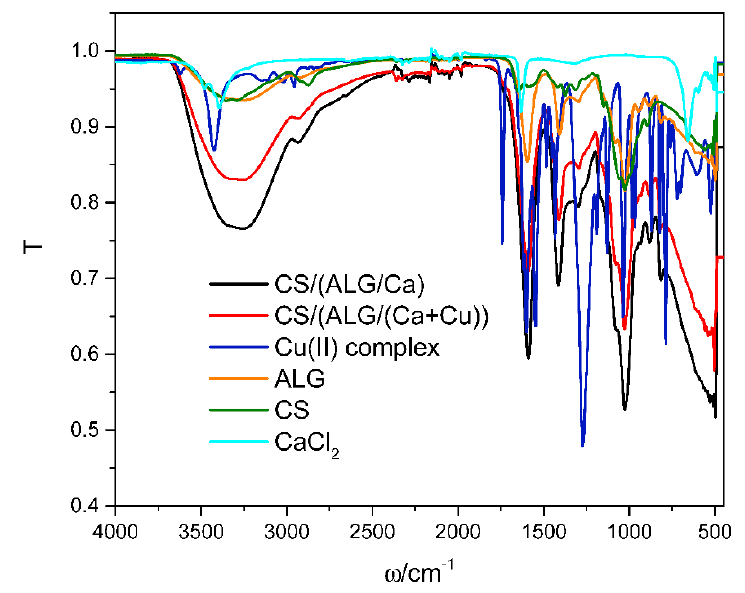
Figure 1. Characteristic FTIR spectrum of dry CS/(ALG/Ca) (black line) and CS/(ALG/(Ca+Cu)) (red line) microcapsules. A spectrum of single components, Cu(II) complex (blue line), ALG (orange line), CS (olive line), and CaCl 2 (cyan line) are added for comparison.